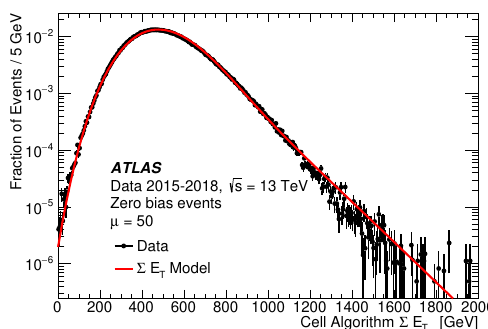
Figure 14. The probability density function P ((cid:6) E T j (cid:22);~(cid:13) ) described in the text is shown and compared with data recorded using a zero bias trigger. The model and the data both correspond to pile-up of h (cid:22) i (cid:25)